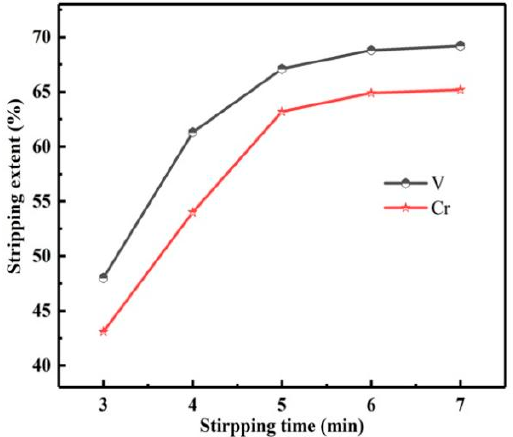
Figure 17. Influence of stripping time on stripping extents of vanadium and chromium.